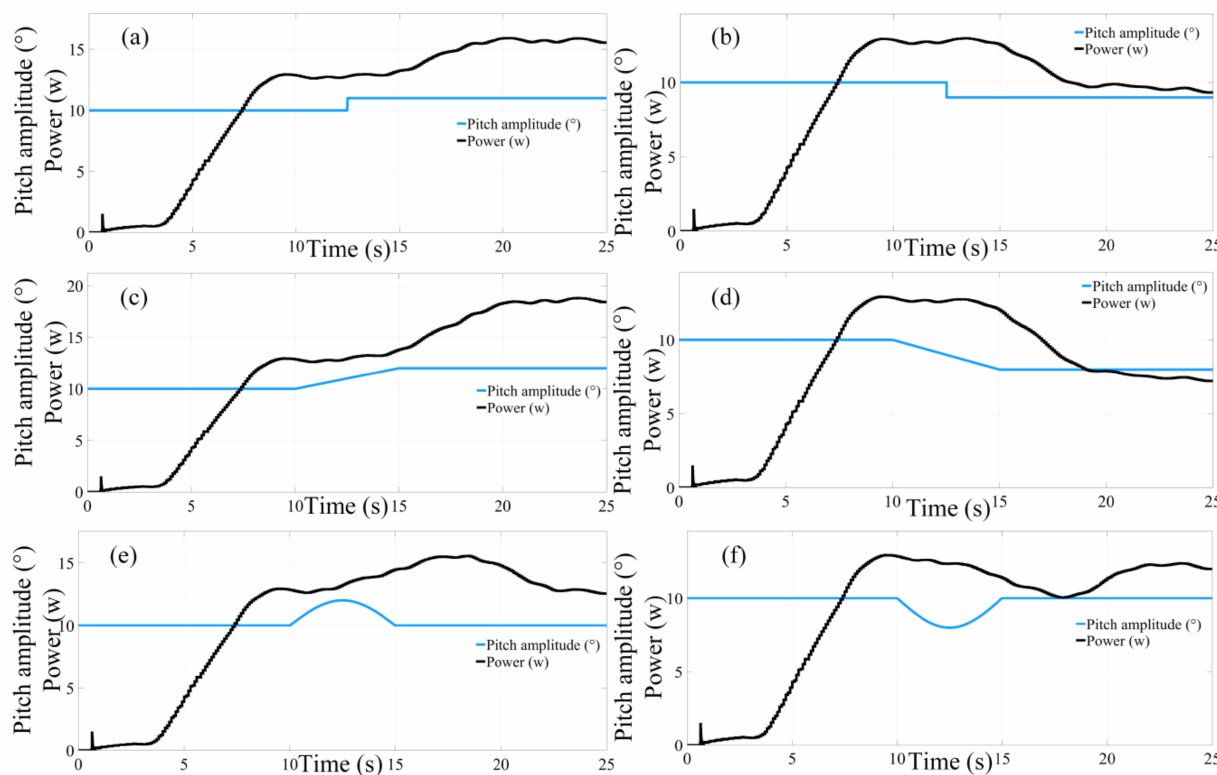
Figure 20. Power output curve under different ocean conditions: ( a ) step signal 10 ◦ − 11 ◦ ; ( b ) step signal 11 ◦ –10 ◦ ; ( c ) ramp signal 10 ◦ –12 ◦ ; ( d ) ramp signal 10 ◦ –8 ◦ ; ( e ) half-sine signal 10 ◦ –12 ◦ –10 ◦ ; ( f ) half-sine signal 10 ◦ –8 ◦ –10 ◦